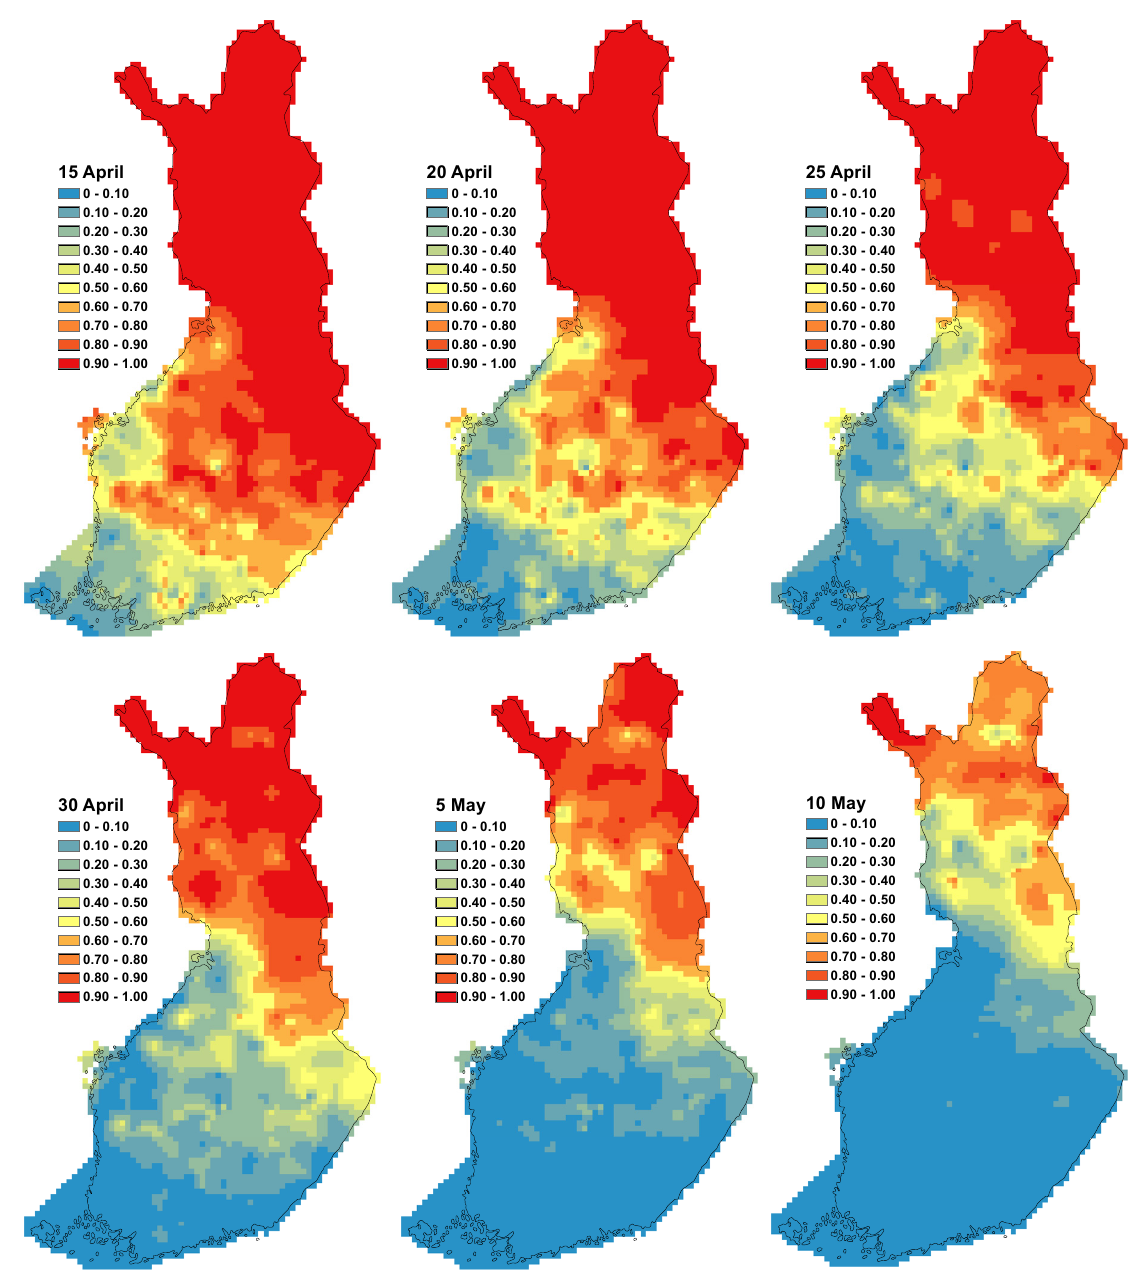
Fig. 1. Probabilities of late snow cover in a five-day intervals from 15 April to 10 May. Thereafter, the likelihood was negligible in agricultural were steep decreases in the risk of mild, moderate and severe night frost in spring depending on the region (Fig. 2). In general, the risk of severe night frost (< –9 °C) ended by early to late May, of moderate frost (< –5 °C) by mid-June and of mild frost (between –2 and –5°C) by the end of June. In some locations such as Seinäjoki, Siika - joki and Rovaniemi, there was up to a 6% probability of mild night frost throughout the growing season. Again, in some locations such as Mietoinen, Kouvola and Maaninka, the night-frost-free period lasted for about one and a half months between late June and around mid-August. The probabilities of mild night frost occurring after sow- ings were often great, up to 30‒50% and for moderate frost up to 30% depending on region.